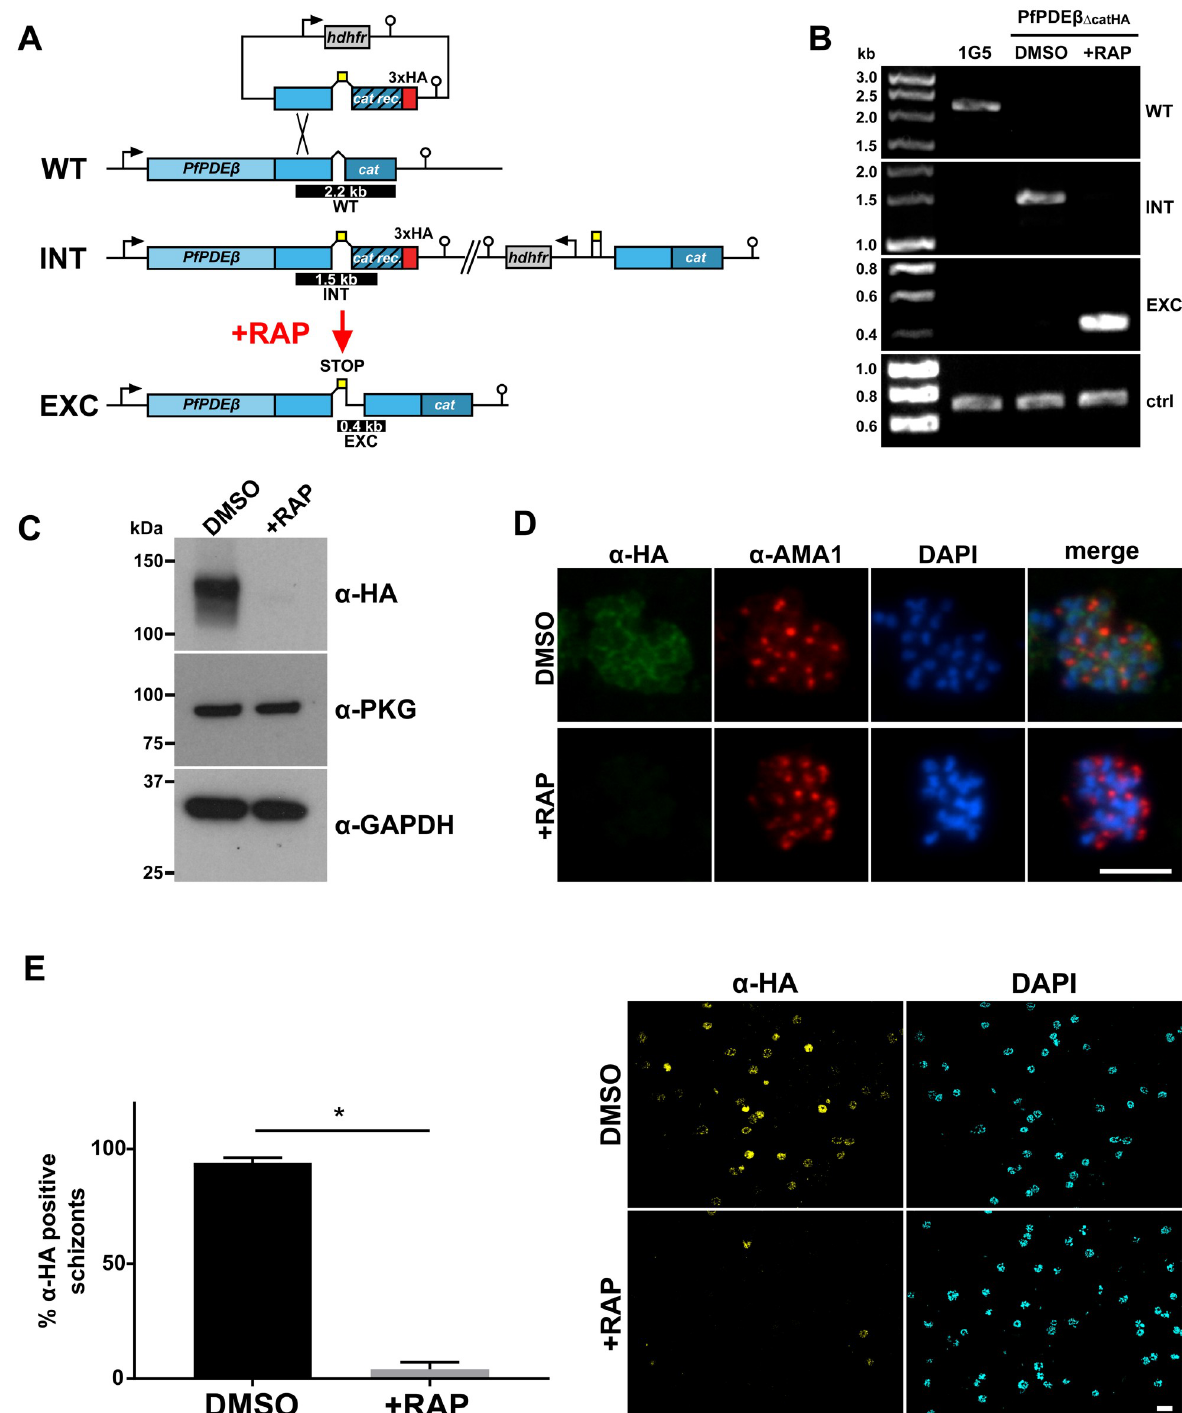
Fig 2. Rapid and efficient conditional disruption of PfPDE β expression. (A) Schematic of the strategy used for generating a conditional PfPDE β knockout line (PfPDE β Δ catHA ) by incorporating loxP sites (yellow boxes) flanking the recodonised catalytic domain (hatched box), a triple HA tag (red), and a hdhfr selection cassette (grey) into the PfPDE β locus of the DiCre-expressing Plasmodium falciparum line 1G5DC. Black arrows denote promoters and lollipops represent transcription terminators. The relative positions are shown of PCR amplicons (black bars) used to confirm the absence of wild-type locus (WT), or correct plasmid integration (INT; introduced by single crossover homologous recombination) into the PfPDE β locus, or RAP-induced excision (EXC) of the floxed sequence. (B) Diagnostic PCR analysis of the PfPDE β locus in the parental 1G5DC line and the